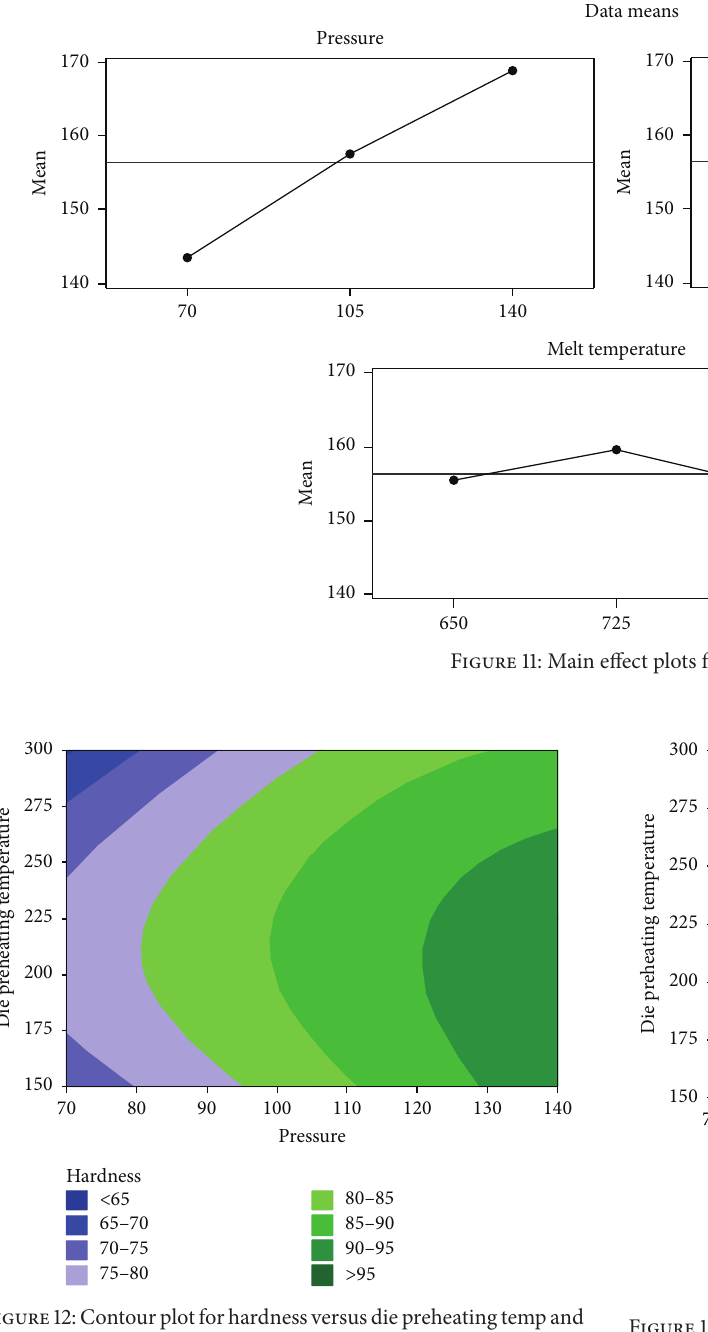
Figure 13: Contour plot for UTS versus die preheating temperature and